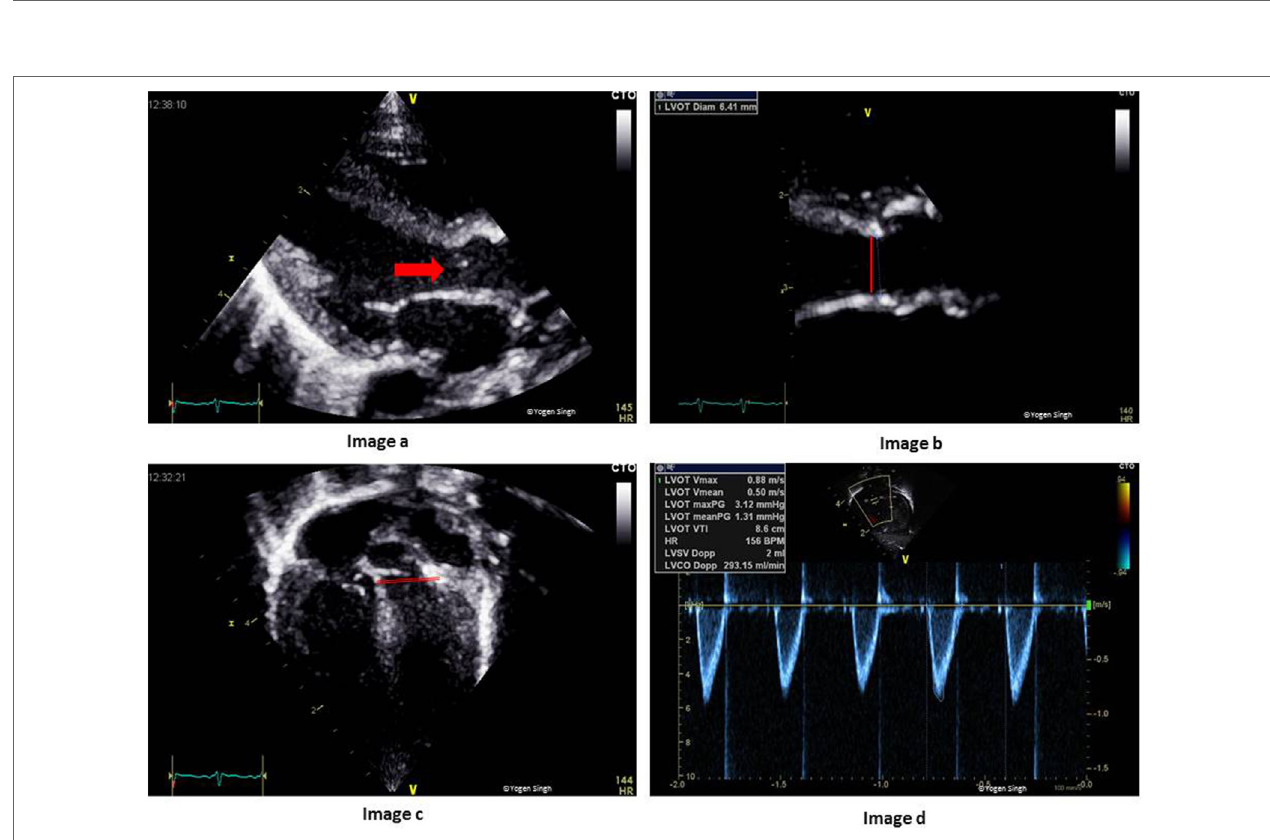
FiGURe 10 | Assessment of left ventricular output (LVO) on echocardiography. Image a shows LV outflow tract (red arrow) and AV annulus (red line), which has been zoomed in image b to measure diameter at the hinge point of AV valve. Image c shows LV outflow tract and the site for PW Doppler to measure VTI (red line showing PW sample gate). Image d shows LVO in milliliters per minute. AV, aortic valve; PW, pulse wave; LV, left ventricle; VTI, velocity time